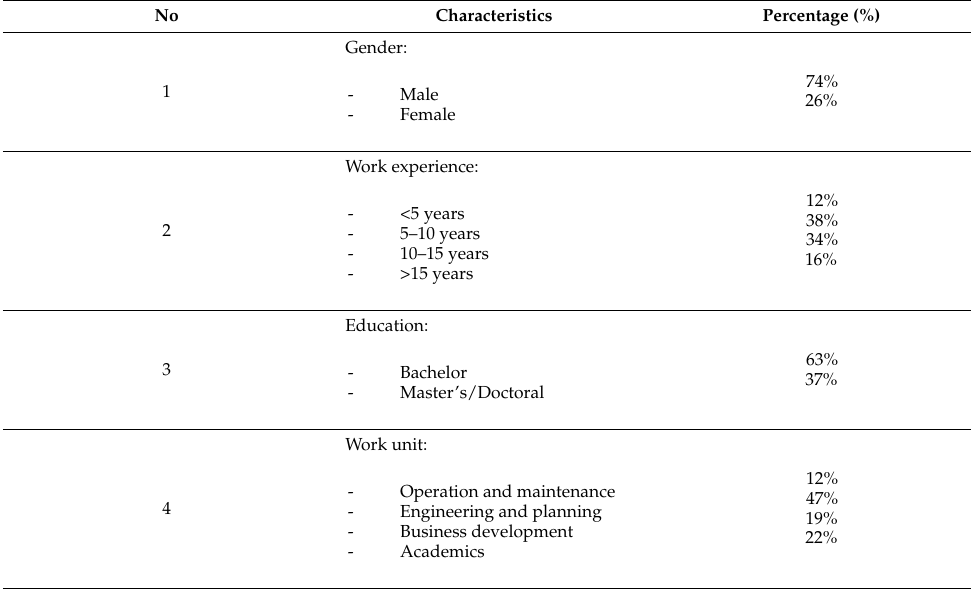
Table 2. Characteristics of informants